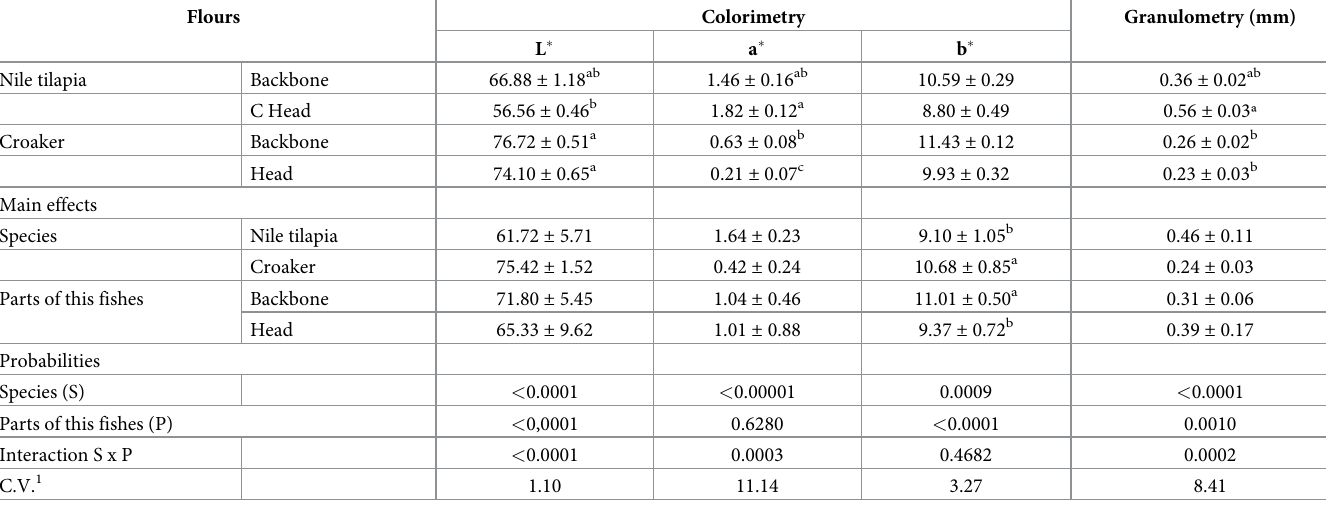
Table 4. Colorimetry and granulometry of flours produced from backbone and head of Nile tilapia and croaker.